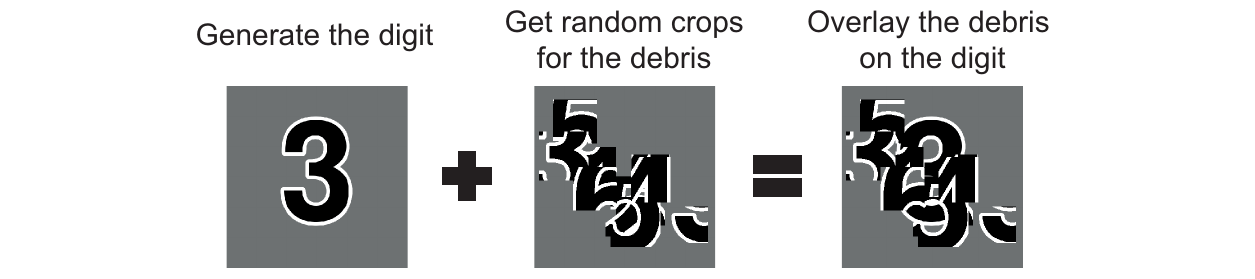
FIGURE 1 | The process for generating stimuli for digit debris. First the target digit is generated. Random crops of all possible targets are taken to create a mask of debris, which is applied to the target as an occluder.